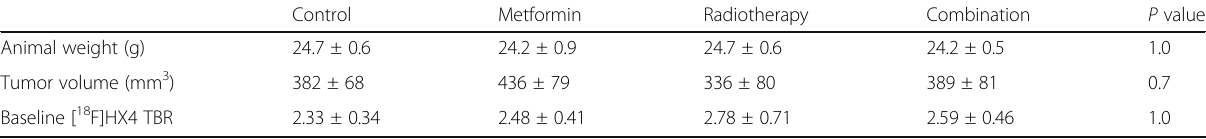
Table 1 Overview of the baseline parameters of the four treatment groups of the imaging study